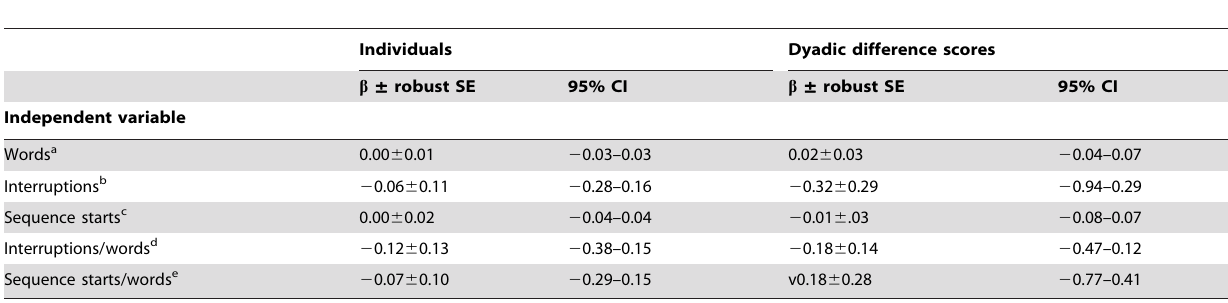
Table 3. Linear regressions of conversational dominance variables on standardized female facial